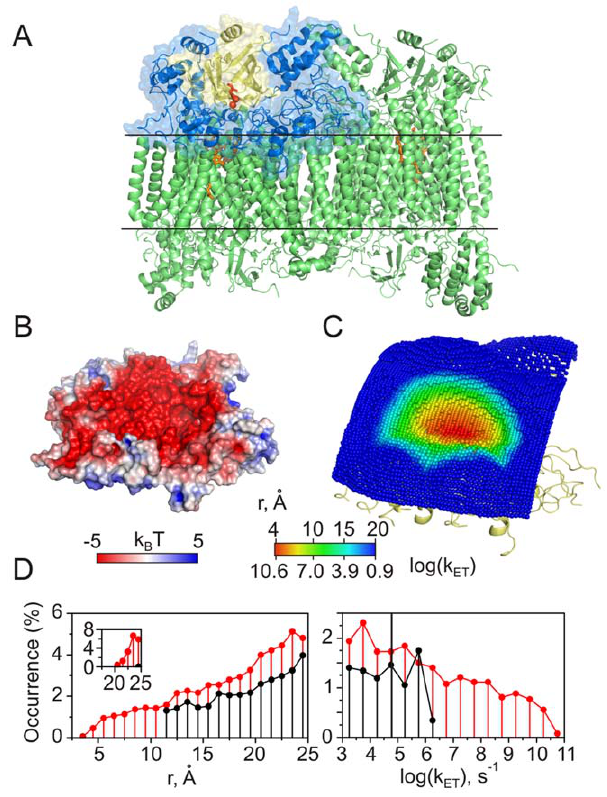
Figure 4. Cc-CCO. (A) Crystal structure of bovine CCO [70]. The intramitochondrial region of the CCO asymmetric unit modeled in this work is shown as a molecular surface. Subunit II is colored yellow, with its dinuclear CuA centre and W104 residue in red. The other CCO redox cofactors are shown in orange. Horizontal lines indicate approximate location of the mitochondrial membrane. (B) The molecular surface of the modeled CCO region coloured by the electrostatic potential (see the scale bar). Protein orientation is the same as in (A). (C) Distribution of Cc CMs around the subunit II colored by the heme-W104 distances and the corresponding ET rates (see the scale bar). Protein orientation is the same as in (A). (D) Distributions of the intermolecular distances (left) and ET rates (right) for heme-W104 (red) and heme-CuA (black). The solid vertical line indicates the fastest experimentally measured intermolecular ET rate in the Cc-CCO system [71]. The inset shows the distance distribution in the ternary complex (see text). biological ET. The experimentally measured intermolecular ET rate is 3–4 orders of magnitude smaller than our estimated k ET limit (Table 1) and 20–350 times slower than the ET rate calculated from the X-ray structure (Figure S3E, left). Differences between the protein-protein orientations in crystal and solution or possible conformational gating of the ET have been advanced as possible explanations for the observed discrepancy [49].